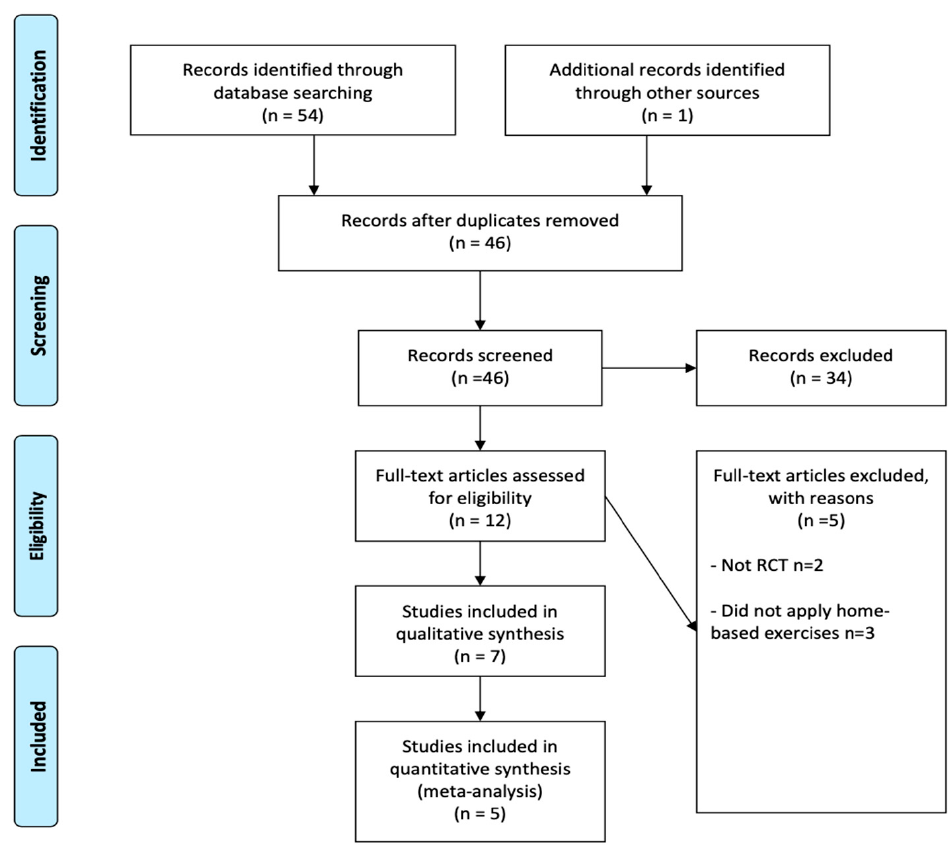
Figure 1. Screening process for systematic review in accordance with PRISMA.